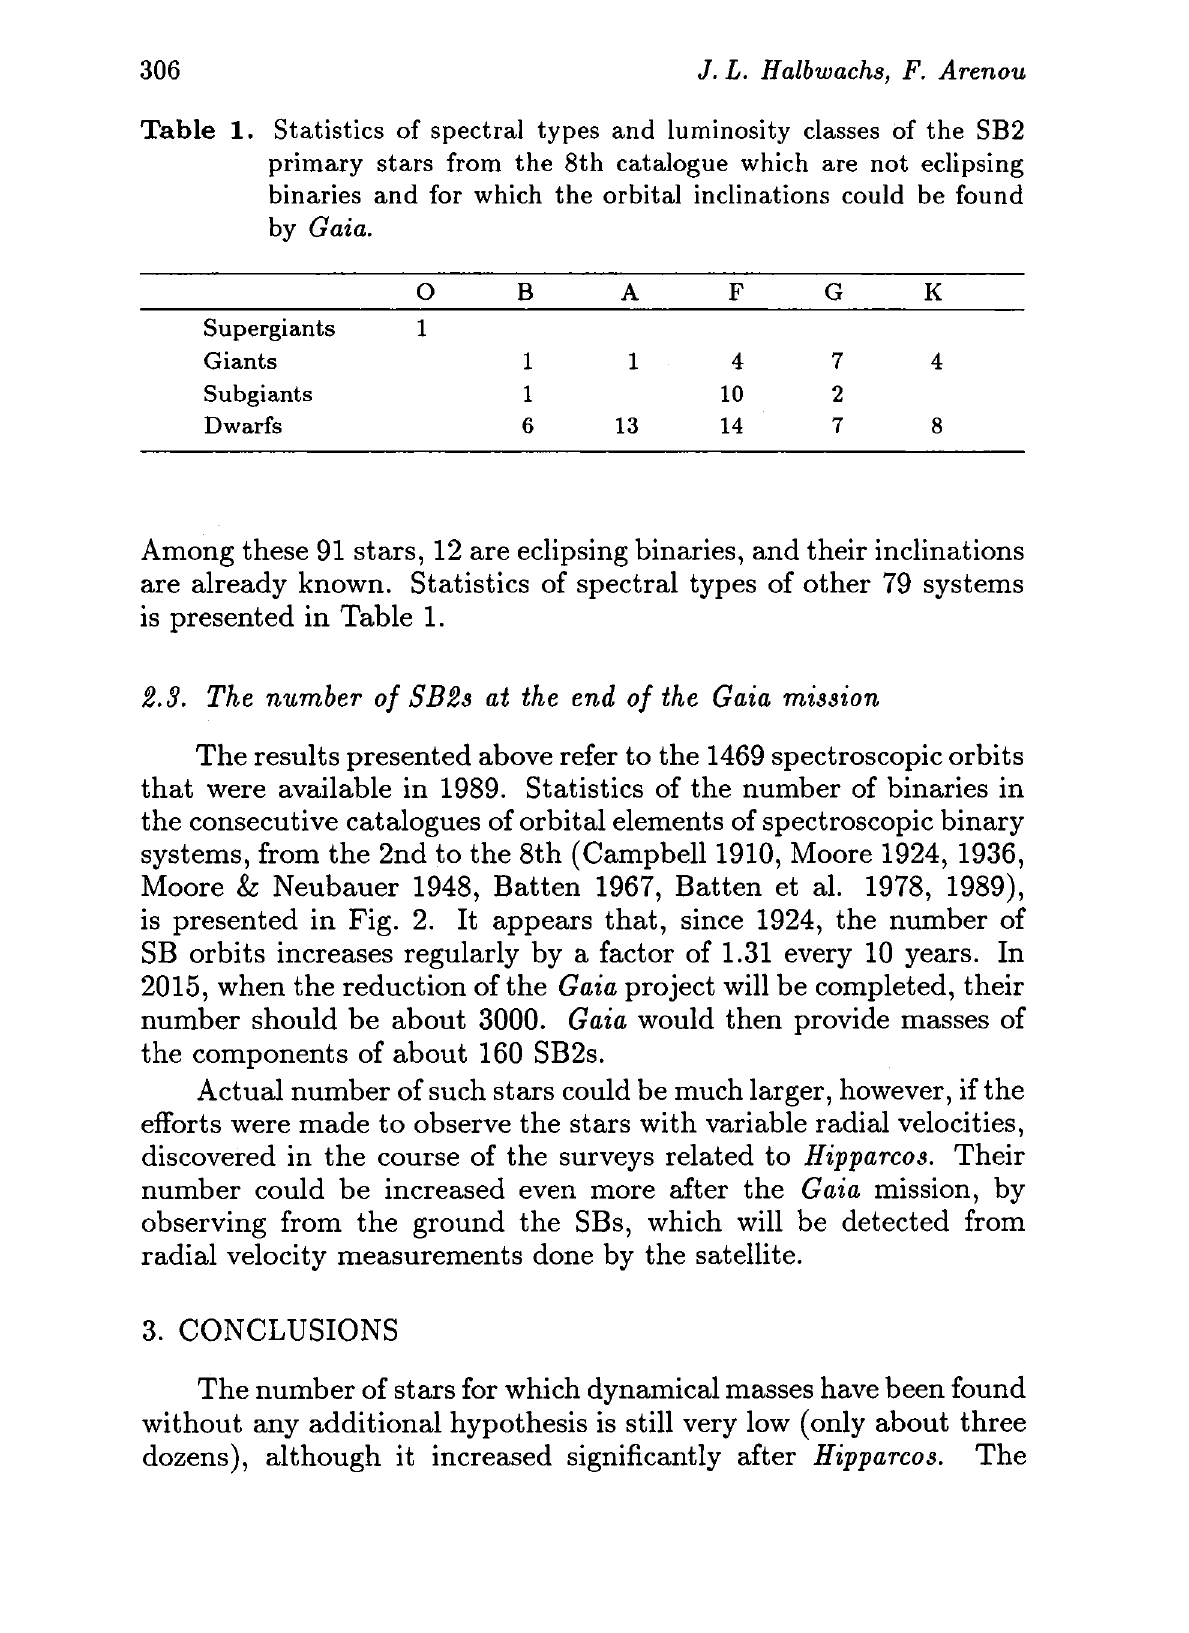
Table 1. Statistics of spectral types and luminosity classes of the SB2 primary stars from the 8th catalogue which are not eclipsing binaries and for which the orbital inclinations could be found by Gaia.